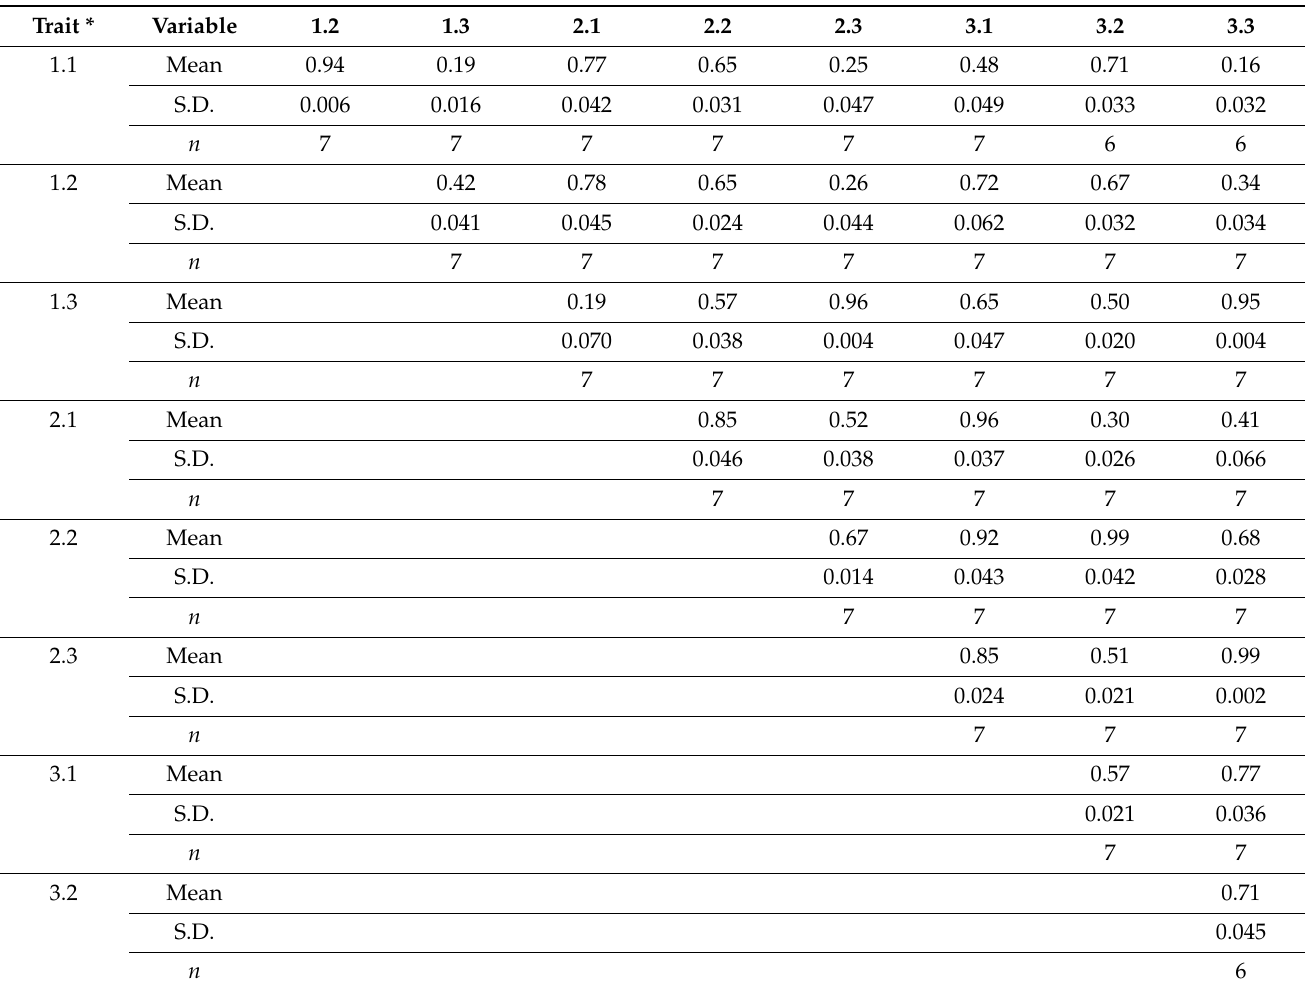
Table 2. Genetic correlation estimates with means, standard deviation, and number of contributing runs ( n